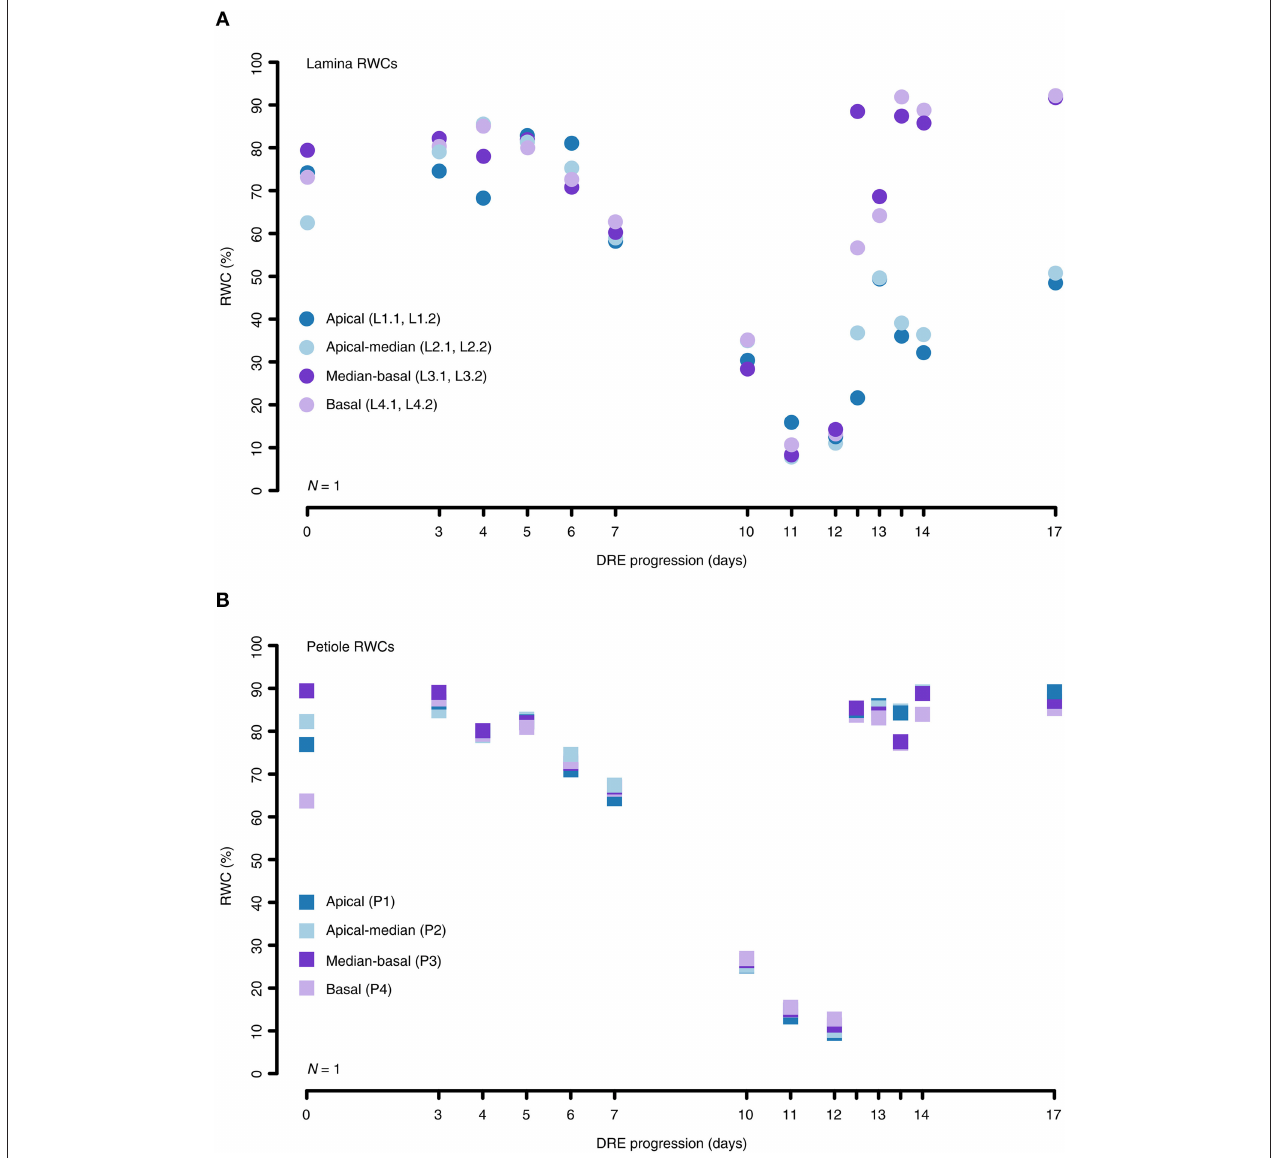
FIGURE 3 | Location-specific RWC alterations of the lamina and petiole of R. myconi during DREs. (A) Different lamina sampling locations (circles) showed that the local RWCs during dehydration hardly differ. However, sometimes apical lamina parts recovered less than basal lamina parts during rehydration. (B) Local RWCs of petiole samples (squares) altered similarly throughout the complete DRE. For reasons of simplification the graph depicts the results of one representative experiment. The origin of each sample is color-coded: blue: apical sampling location; light-blue: apical-to-median sampling location; purple: median-to-basal sampling location; light-purple: basal sampling location. Further information on individual sampling locations is given in parentheses and Figure 1B . Dehydrated samples were collected from day 0 to day 12, whereas progressively rehydrated samples were gathered after last dehydration measurement on day